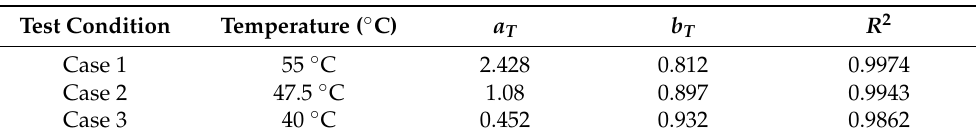
Figure 8. Effect of storage time and temperature on the decrease of the capacity (at 50% SOC level). Table 3. The curve fitting coefficients of the capacity fade model considering the temperature variation (SOC level is fixed to 50%).